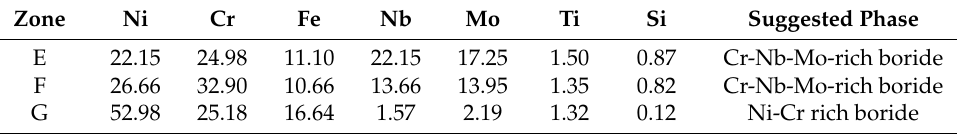
Figure 3. Backscatter FE-SEM images of the diffusion-affected zone of GH4169. Table 3. Chemical composition (wt.%) of different zones marked in Figure 3.